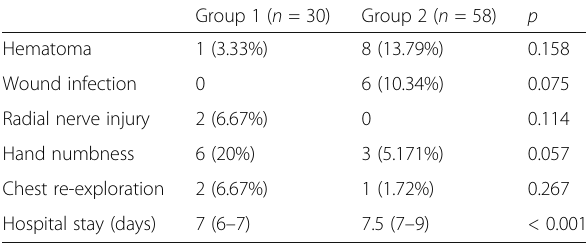
Table 3 Comparison of the operative outcomes between both groups